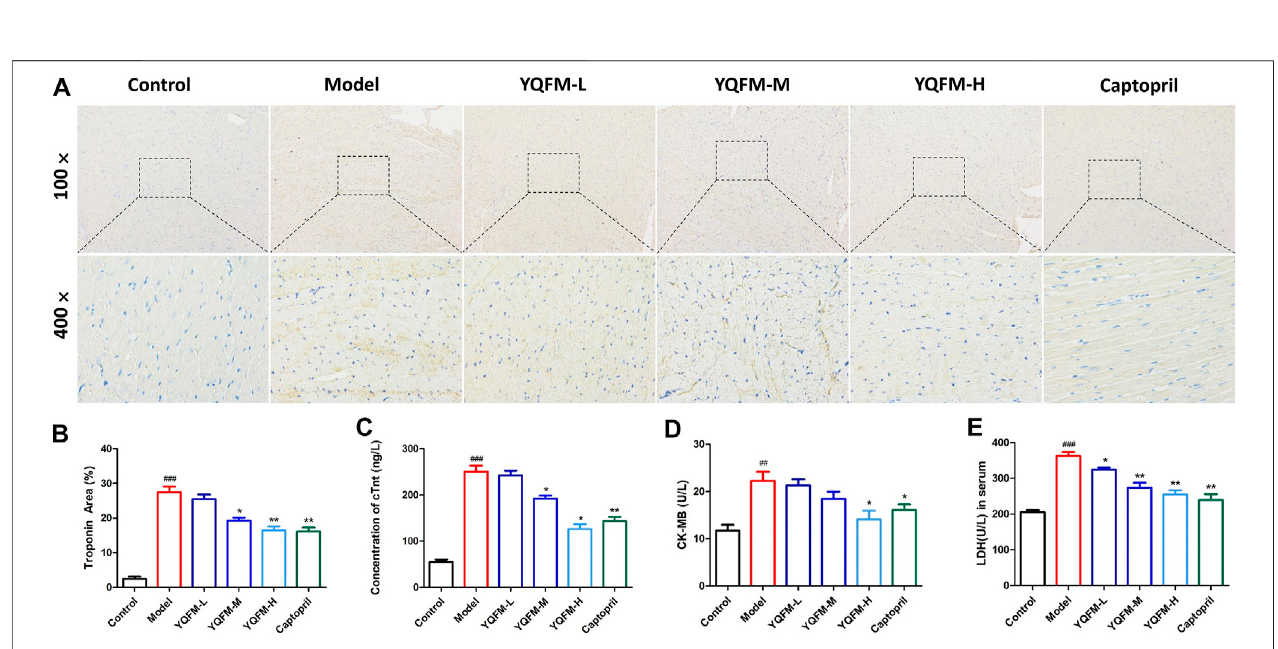
FIGURE4| TheeffectofYQFMonCardiacMorphologyinCHFratafterbeingtreatedfor28 days. (A , B) ImmunohistochemistryanalysisofcTntexpressioninheart sectionsofdifferentgroups.Thediseasedareasintheheartaremagni fi edinthepanelbelow( n (cid:2) 3pergroup).ConcentrationofcTnt (C) ,CK-MB (D) andLDH (E) inCHF ratafterbeingtreatedfor28 days( n (cid:2) 6animals/group).Dataaremeans ± SD.* p < 0.05,** p < 0.01,*** p < 0.001vstheModelgroup, # p < 0.05, ## p < 0.01, ### p < 0.001 vs the Control group.